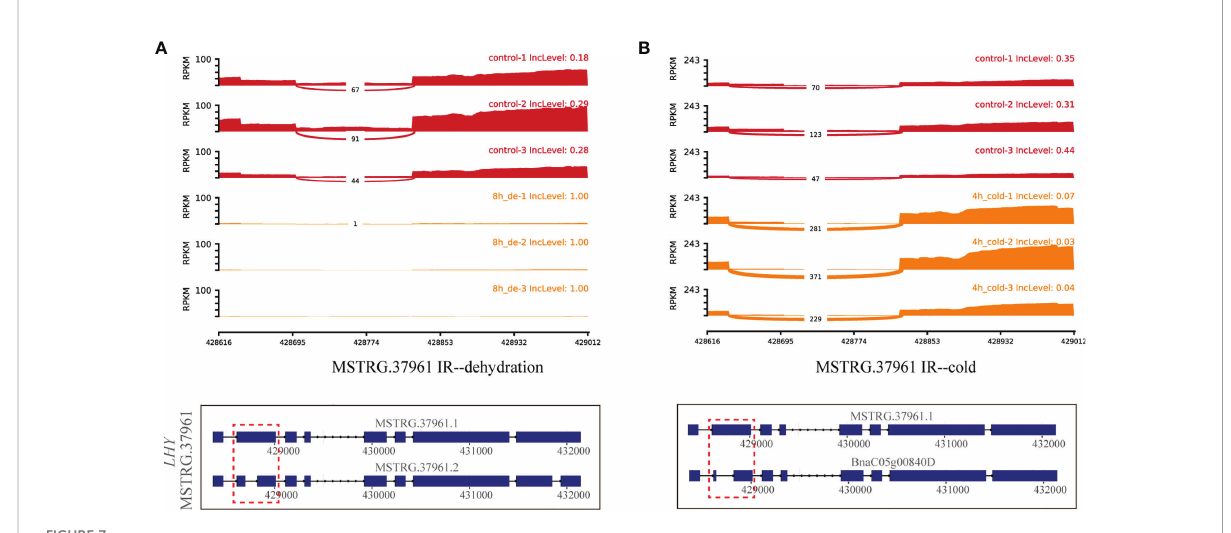
FIGURE 7 Quantitative visualization (sashimiplot) and transcripts structures of the DAS gene ( MSTRG.37961 , TF) under multiple abiotic stresses. Panels (A, B) represent dehydration and cold stress, respectively. Red dashed box indicates exons and introns shown in sashimiplots corresponding to gene structures below. The IncLevel value represents the normalized proportion of AS event. The red color denotes control, and orange color denotes treatments. The blue rectangular boxes denote the exons, the lines denote the introns, and the arrows denote the transcriptional direction.